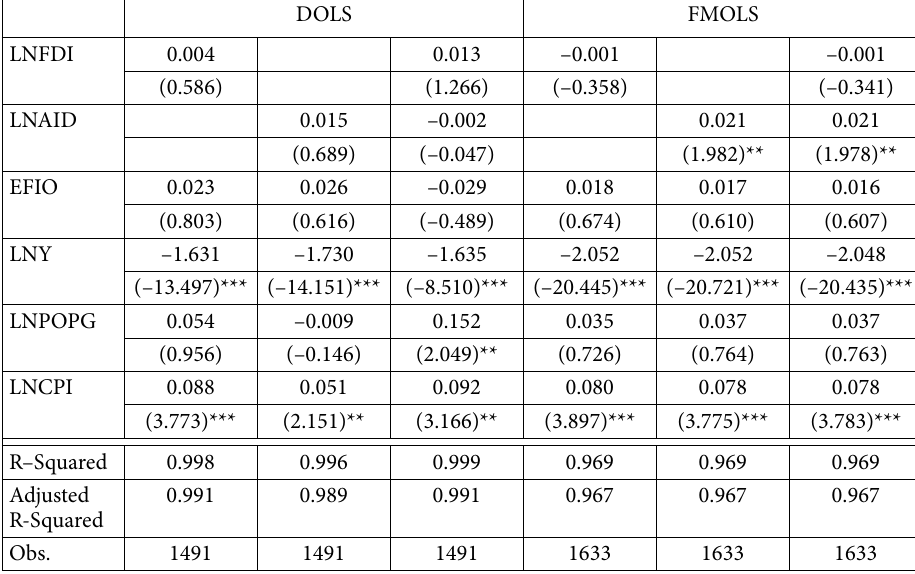
Table 7. Results from Dynamic ordinary least square (DOLS) and fully modified least square (FMOLS): All